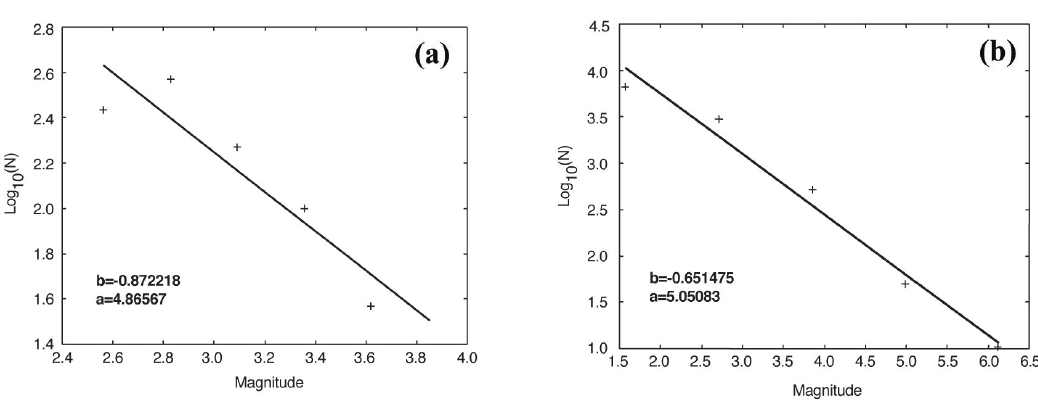
Figure 4. (a) Gutenberg–Richter distribution of events recorded with the prototype during a series of 736 events. (b) Gutenberg–Richter distribution of earthquakes recorded in California between 1980 and 2000 (10,256